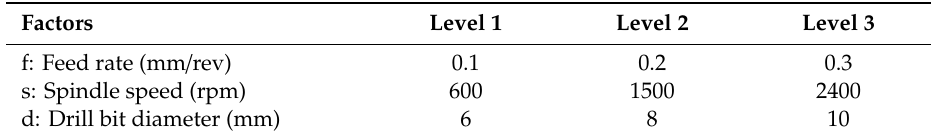
Table 3. The design of